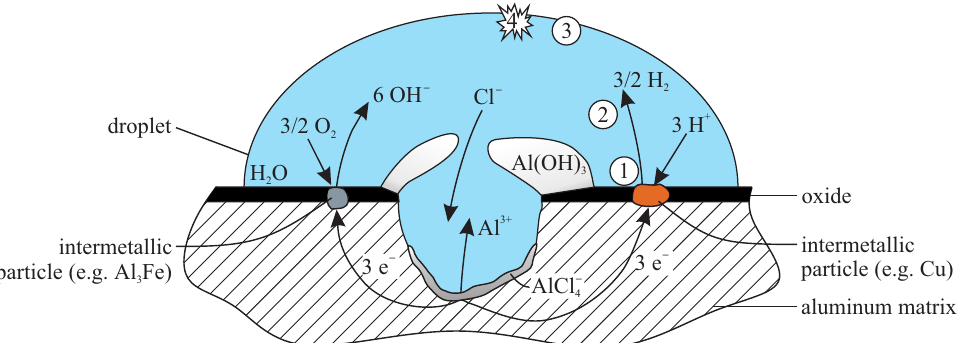
Figure 1. Mechanism of pitting corrosion of aluminum under a droplet of an aqueous solution [6]. H 2 bubble activity is distinguished into the following phases: 1 (cid:13) formation , 2 (cid:13) detachment from metal surface and movement, 3 (cid:13) arrival at droplet surface and growth, and 4 (cid:13) bursting of H 2